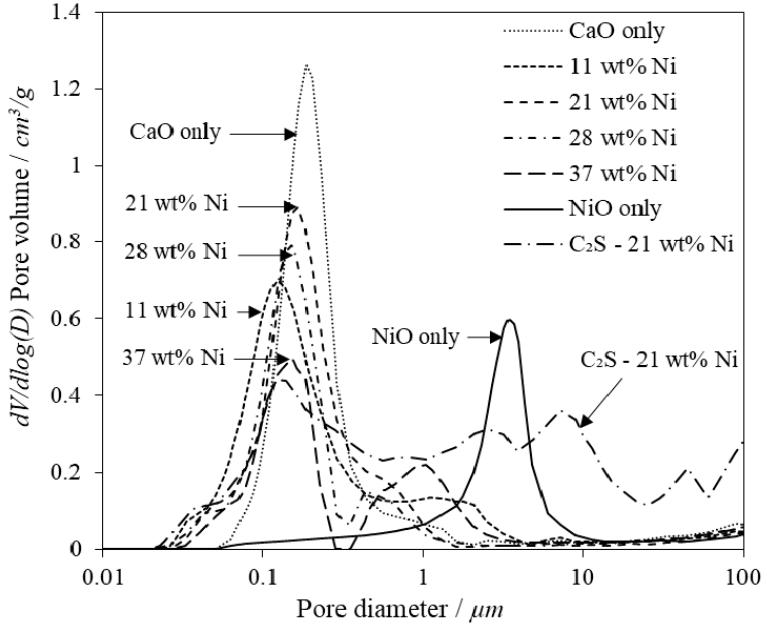
Figure 3. Pore volume distribution, dV/dlog ( D ), from Mercury Intrusion Porosimetry (MIP) analysis for combined particles of various compositions.